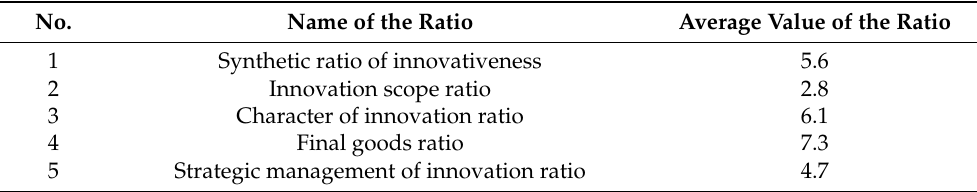
Table 3. Average values of innovativeness ratios for the studied enterprises.